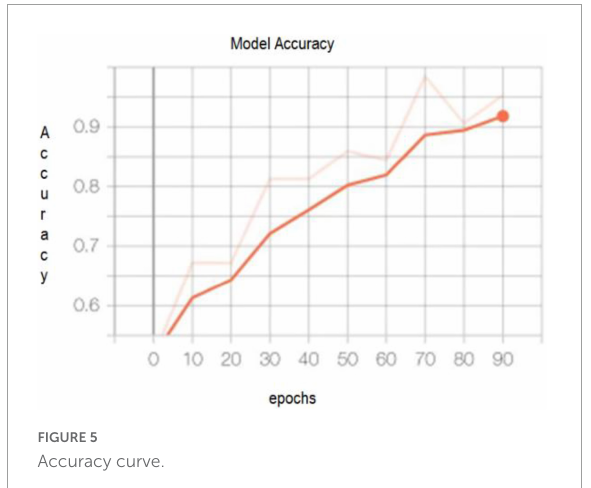
FIGURE5 Accuracy curve.